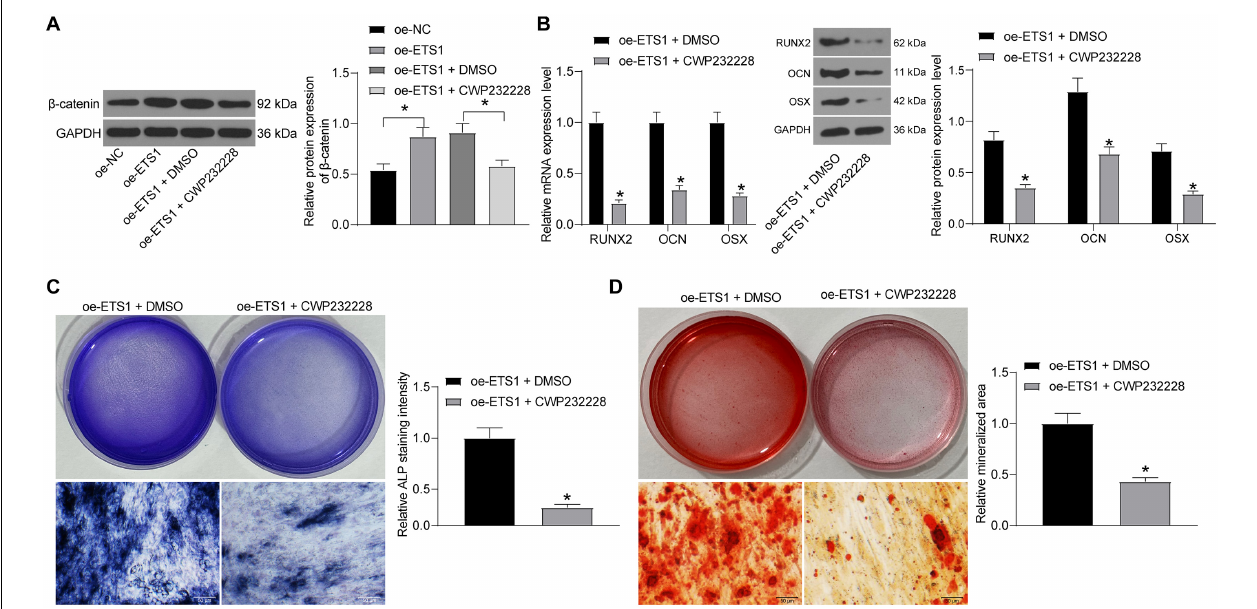
FIGURE 7 | Inhibition of β -catenin blocks the promotion of oe-ETS1 on osteogenic differentiation. (A) Protein expression of β -catenin in MC3T3-E1 cells after CWP232228 administration determined by western blot analysis (one-way ANOVA, * p < 0.05). (B) mRNA and protein expression of RUNX2, OCN, and OSX in cells on day 7 determined by RT-qPCR and western blot analysis, respectively (two-way ANOVA, * p < 0.05). (C) ALP concentration in cells measured by ALP staining (unpaired t -test, * p < 0.05). (D) Calcareous accumulation in cells on day 21 evaluated by ARS staining (unpaired t -test, * p < 0.05).